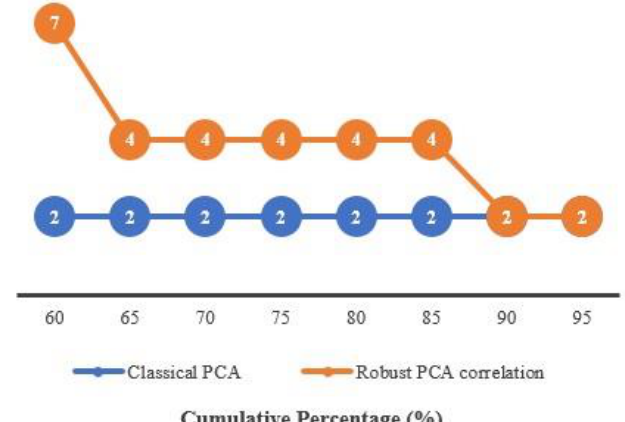
Figure 7. The number of clusters obtained based on using the classical PCA against the RPCA correlation using torrential rainfall data from East Coast Peninsular Malaysia.